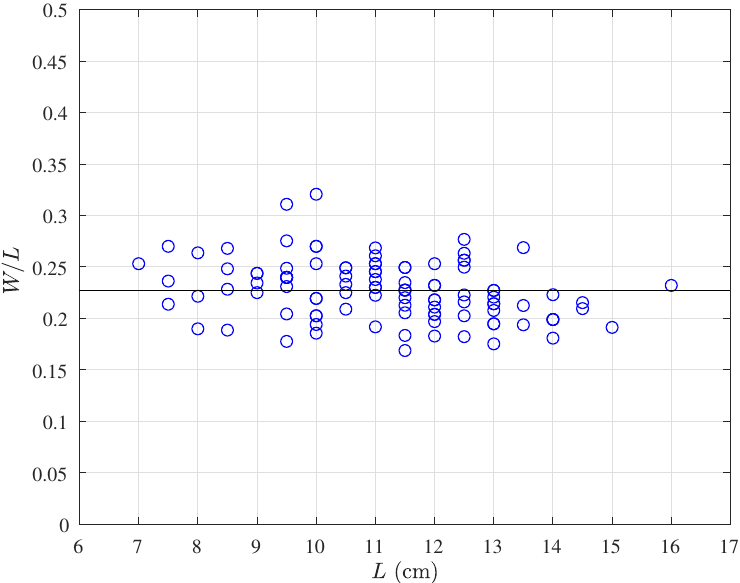
Figure 5. Arm width of Asterias rubens as function of length calculated from the direct measurement of W (cid:48) using (9). The solid line corresponds to